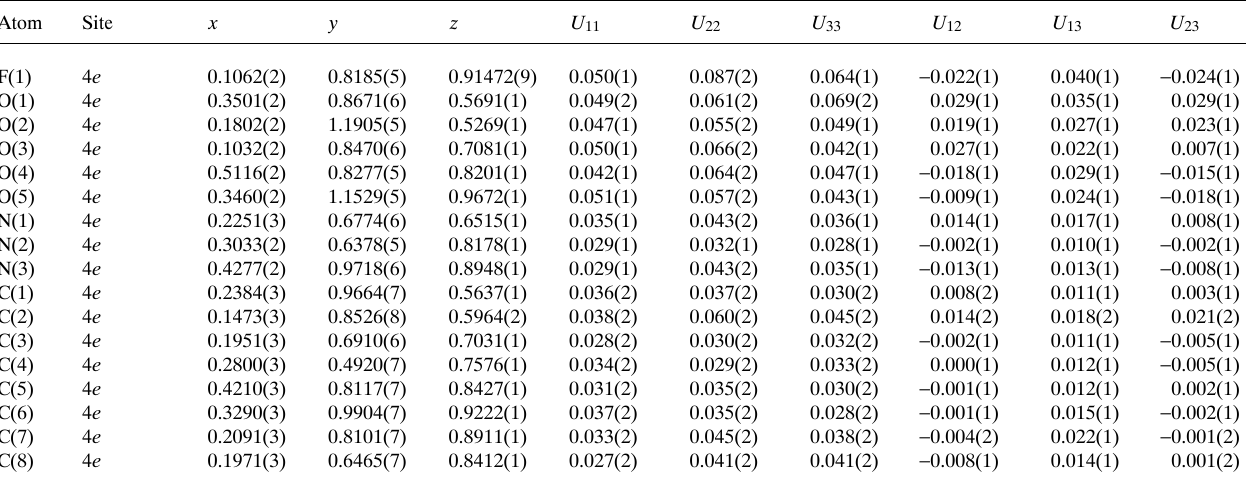
Table 3. A tomic coordin a tes a nd displ a cement p a r a meters (in Å 2 )